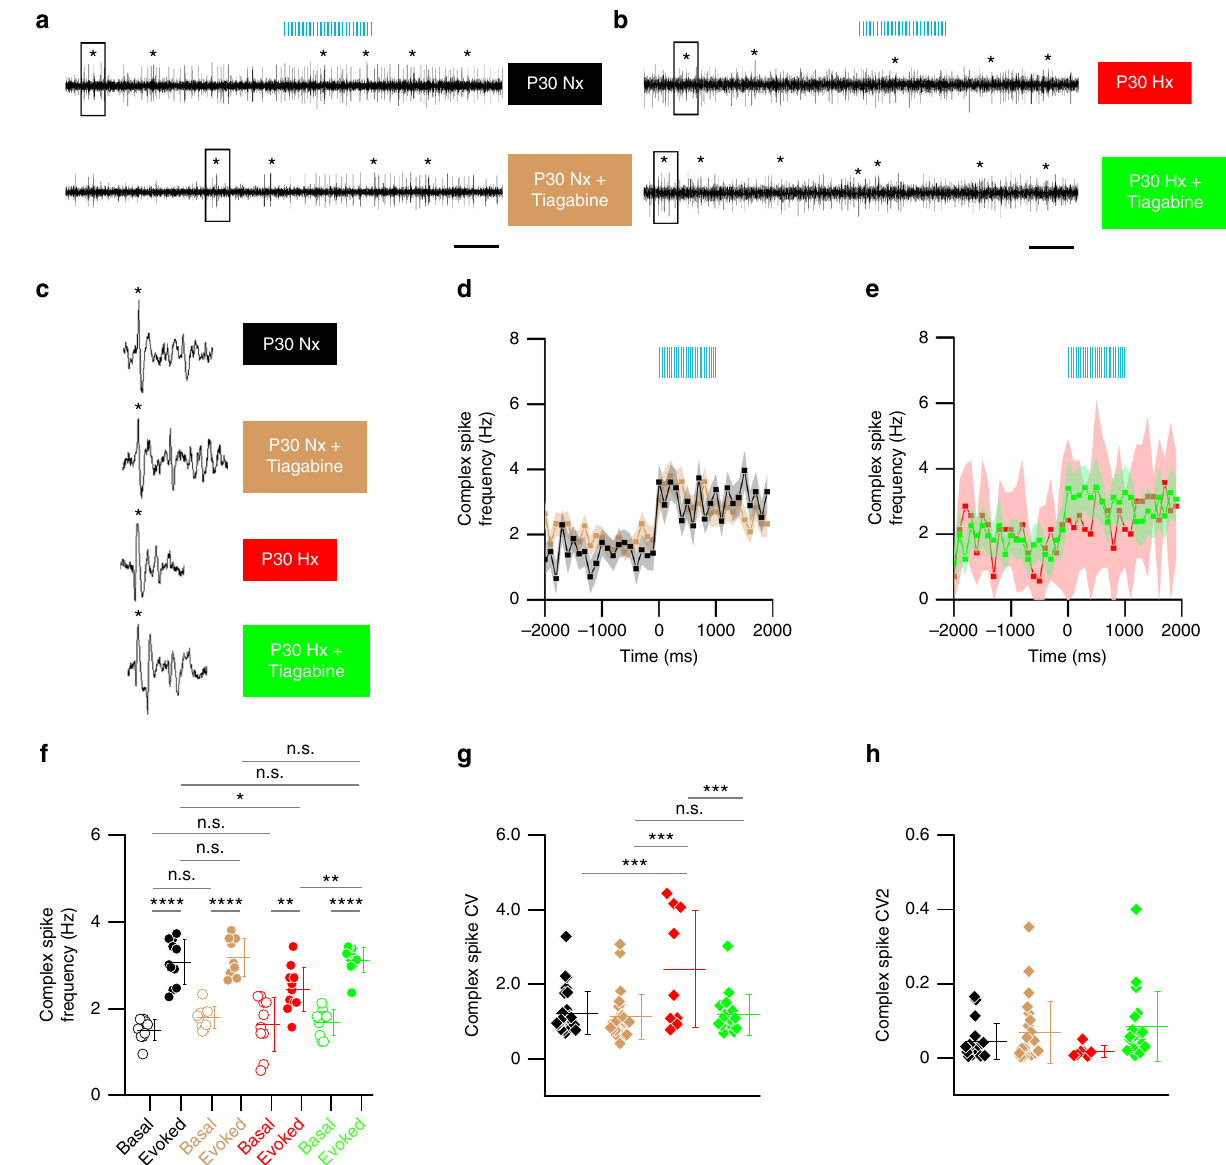
Fig. 9 Pharmacological intervention restores complex spike fi ring to near-normal levels in Hx mice in vivo. a Representative MEA recordings from P30 Nx (black), P30 Nx treated (light brown), b P30 Hx untreated (red), P30 Hx treated (green) showing complex spikes (CSs) (Asterisks). Scale 500 ms. c Representative CSs corresponding to spikes within boxes in a shown with increased resolution. Asterisk marks primary spike of CS, which is followed by characteristic spikelets. d Mean CS frequency for P30 animals from untreated Nx (black, n = 28 PCs, SEM — light grey), Tiagabine-treated Nx (light brown, n = 28 PCs SEM — light tan), e untreated Hx (red, n = 9 PCs, SEM — light red), and Tiagabine-treated Hx (green, n = 18 PCs, SEM — light green) groups obtained from 8 to 10 animals/group. f Scatter plot CS frequency comparison across groups as indicated by legend in a and b . For all groups, open circles represent basal fi ring and solid circles represent evoked (optostimulated) fi ring. Each circle represents mean fi ring frequency obtained from multiple cells/ group for one sample. Ten successive timepoints were sampled pre-optostimulation and 11 successive timepoints were sampled post-optostimulation. Horizontal lines in each group represent the mean fi ring frequency across time-samples. One-way ANOVA, F (7,76) = 31.86, P < 0.0001, R 2 = 0.7458. g Scatter plot showing coef fi cient of variance of interspike interval (CV) values for basal PC fi ring in Nx and Hx animals. Each diamond represents individual CV values from the same set of PCs analyzed in d – f . (One-way ANOVA, F (3,79) = 7.378, P = 0.0002, R 2 = 0.2189). h Scatter plot showing CV2 for basal PC fi ring in Nx and Hx animals from the same data set as in d – f . (One-way ANOVA, F (3,66) = 1.898, P = 0.1386, R 2 = 0.07941). Scale in a and b represent 500 ms. Error bars in b – e denote SEM. Asterisks represent results of Tukey ’ s multiple comparison test following one-way ANOVA, * P < 0.05, *** P < 0.001, **** P < 0.0001, n.s. — not signi fi